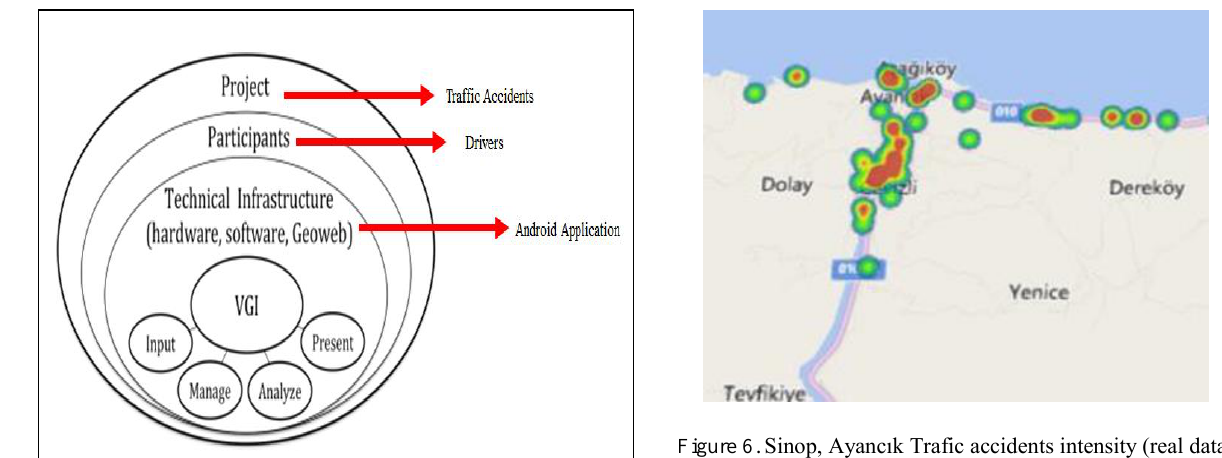
Figure 6. Sinop, Ayancık Trafic accidents intensity (real data)